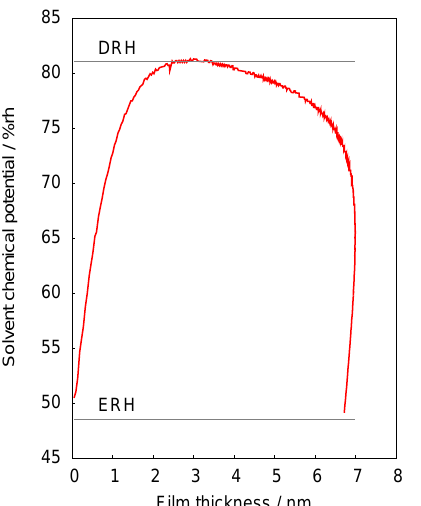
Figure 6. Drop radius R as a function of residual radius R (cid:48) numerical solution of the Ostwald–Freundlich equation (3) at R N =